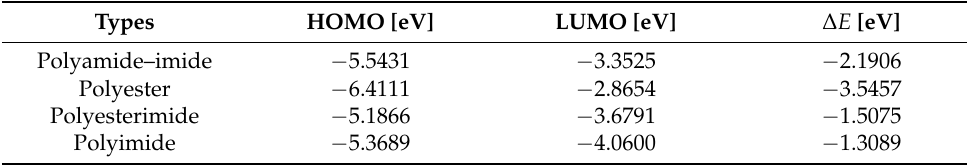
Table 2. HOMO, LUMO and Energy gap of PAI, PET, PEI and